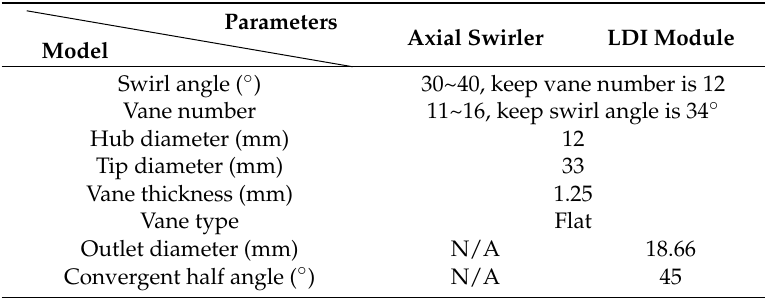
Table 1. Parameters of axial swirlers and LDI modules.